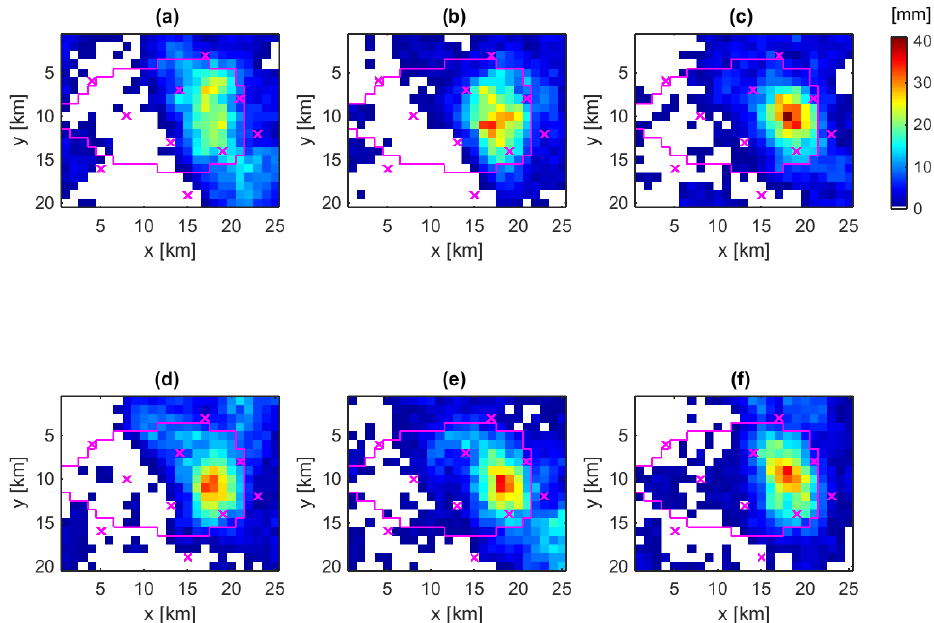
Figure 9. Selected realisations of spatial rainfall amounts per event with similar performance in resulting runoff, obtained by the inverse modelling approach for simulating spatio-temporal rainfall pattern: (a) realisation with the smallest area above 20mmevent − 1 and smallest intensity, (b) realisation with the largest area above 20mmevent − 1 (c) realisation with the highest intensity and rainfall amount per event, (d) realisation with the best NSE value in resulting runoff, and (e) – (f) realisations with similar event statistics to the true spatio-temporal rainfall